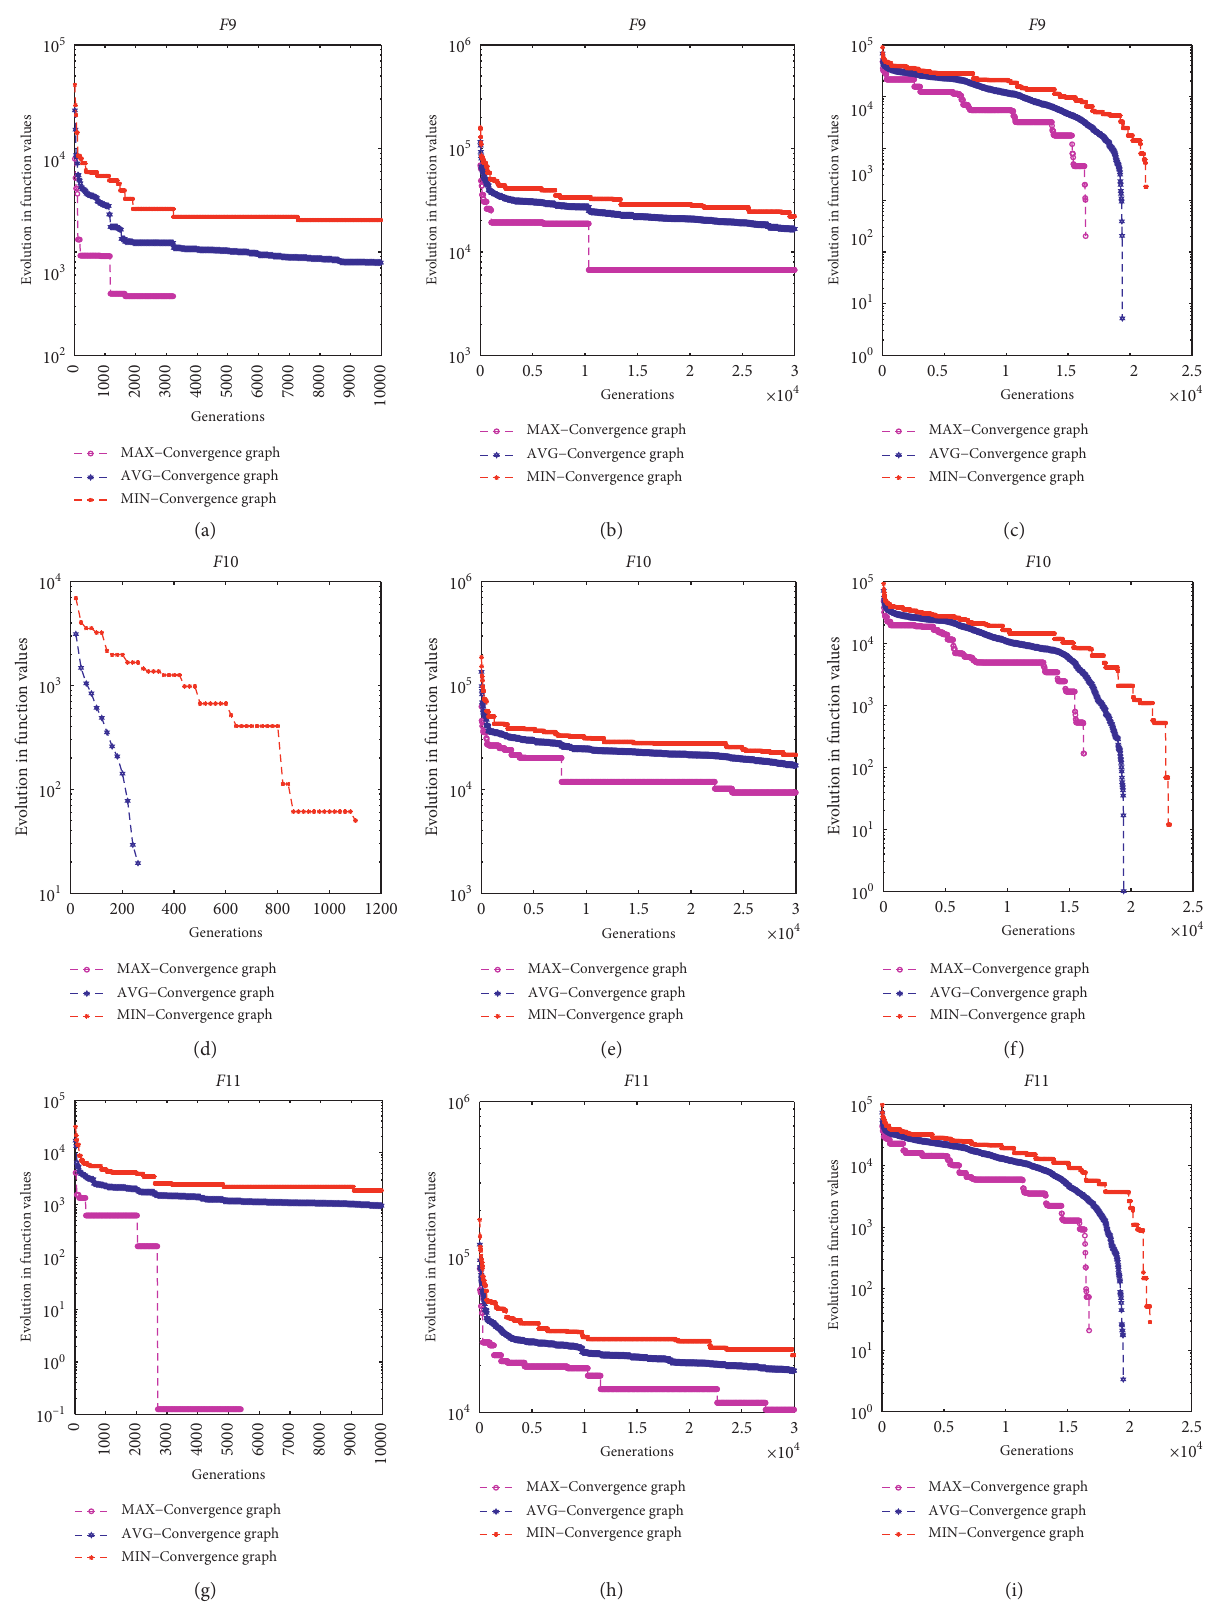
Figure 5: The evolution in maximum, average, and minimum function values displayed by the proposed MSIA solving F functions [54]. The first panel is with respect to n � 10, the second panel is with respect to n � 30, and the third panel is with respect to n � 50 decision